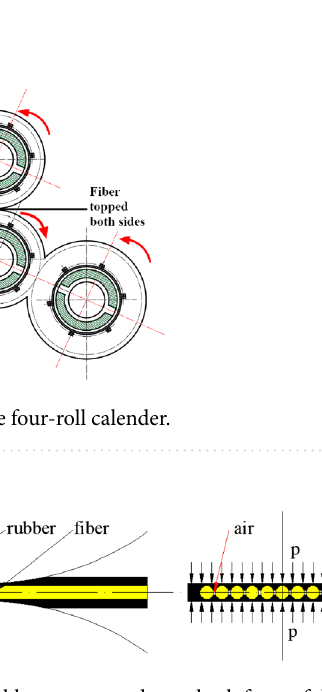
Figure 5. Top the rubber compound onto both faces of the fiber, with some air contained in the rubber/fiber composite.